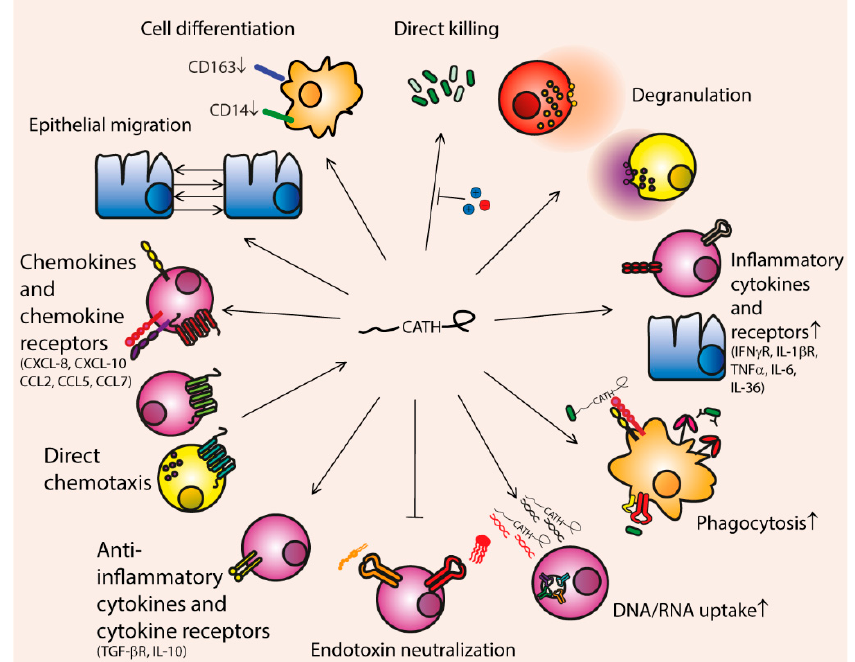
Figure 1. Summary of cathelicidin functions. Cathelicidins have direct killing activity against (among other pathogens) both Gram-positive and Gram-negative bacteria, but this activity is inhibited by the presence of salts. They can induce degranulation of neutrophils and mast cells, induce upregulation of inflammatory cytokines and cytokine receptors, enhance phagocytosis by opsonizing bacteria and upregulating bacterial recognition receptors, and enhance DNA/RNA uptake, thereby boosting intracellular toll-like receptor (TLR) signaling. Furthermore, they can inhibit endotoxin mediated activation of TLR2 and 4 by binding to lipoteichoic acid (LTA) and liposaccharide (LPS), respectively, and directly induce upregulation of anti-inflammatory molecules IL-10 and TGF- β R. They are directly chemotactic for mast cells through the MrgX2 receptor, and for other cells through the FPRL1 receptor; but can also induce production of a variety of chemokines and chemokine receptors, including CCL2, CCL5, CCL7, CXCL8 (IL-8) and CXCL10. They can also induce migration of epithelial cells and